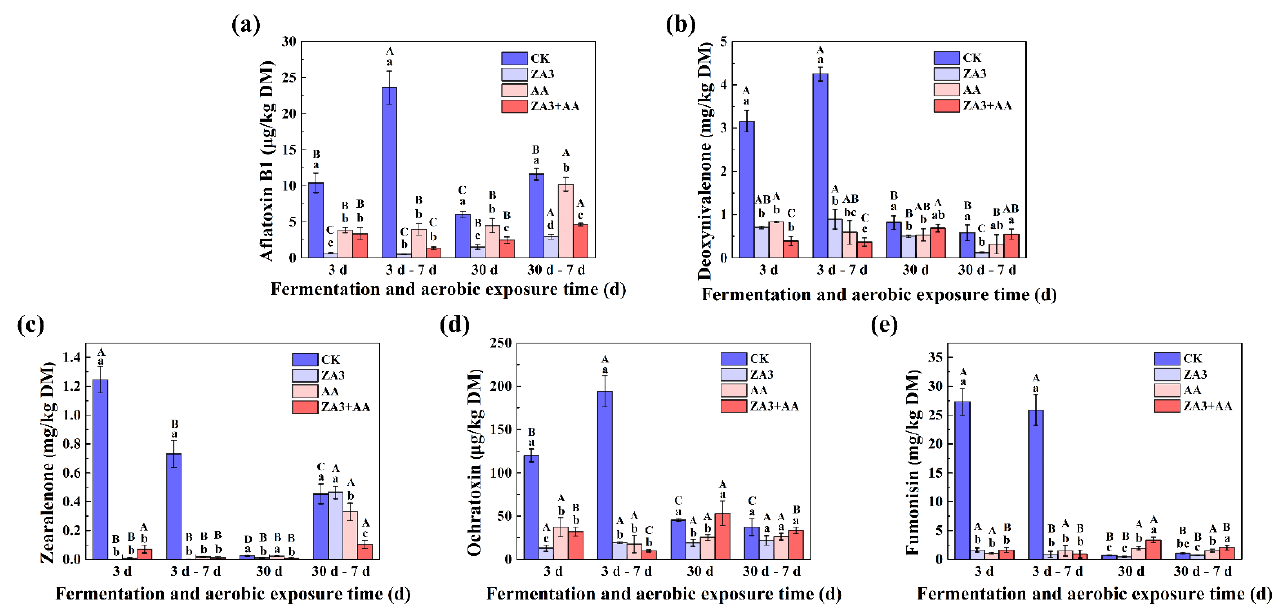
Figure 8. Content of toxin during fermentation and aerobic exposure. ( a ), aflatoxin B1 (μg/kg DM); ( b ), deoxynivalenone (mg/kg DM); ( c ), zearalenone (mg/kg DM); ( d ), fumonisin (mg/kg DM) and ( e ), ochratoxin (μg/kg DM). Different lowercase letters (a–d) for the same treatment time indicate significant differences ( p < 0.05) among different treatment groups. Different capital letters (A–D) for the same treatment groups indicate significant differences among different treatment times ( p < 0.05) according to Student – Newman – Keuls test. d, days.